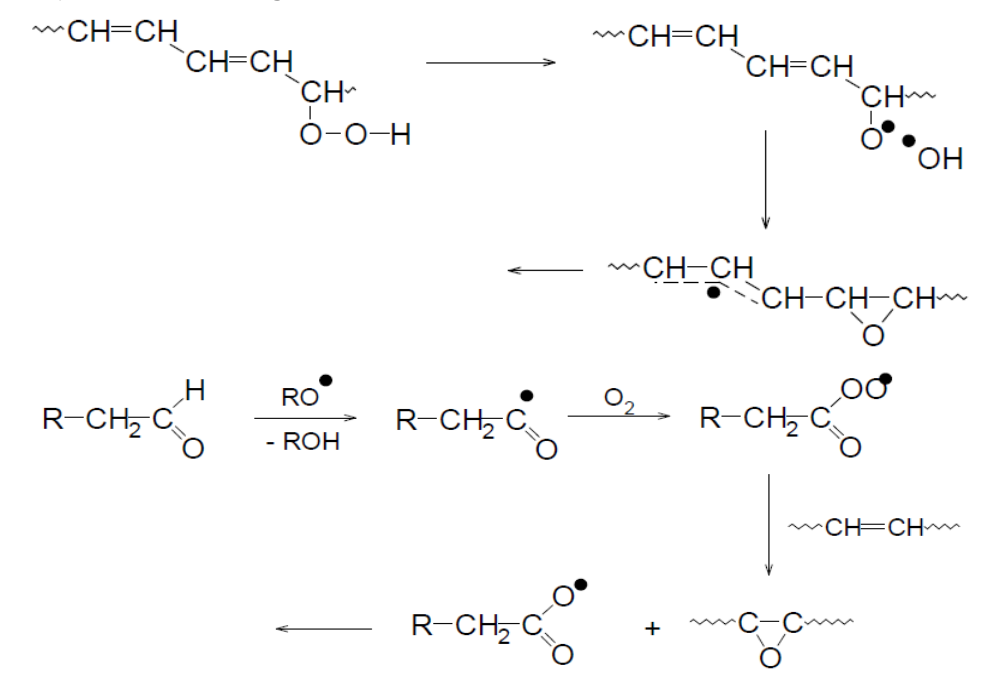
Figure 3. Possible ways of forming epoxies during